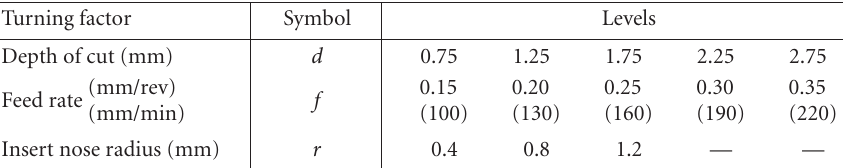
Table 3: Design factors and their levels for AISI